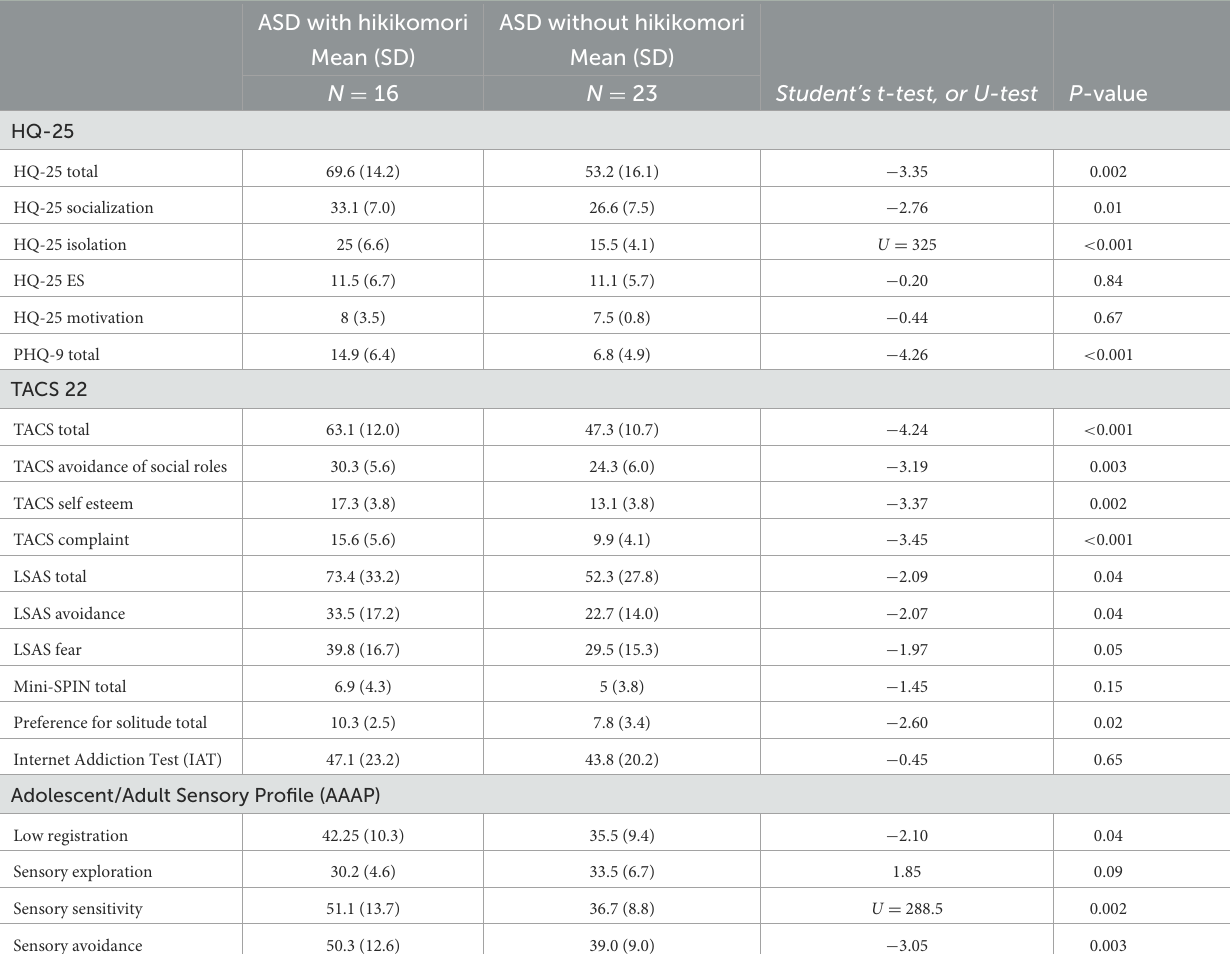
TABLE 2 Self-rated